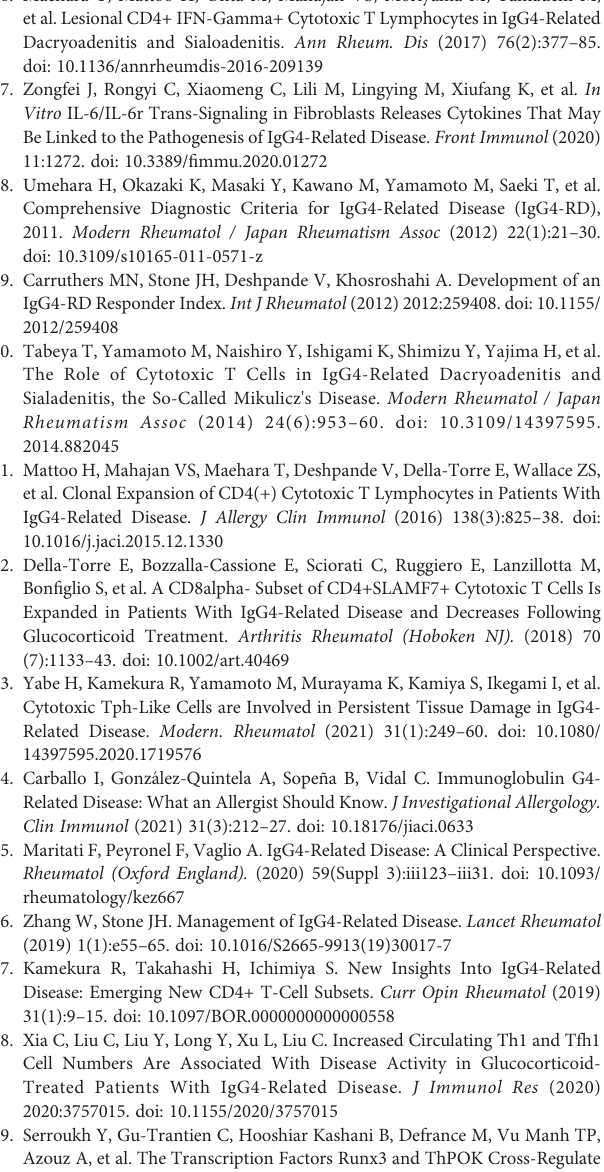
RD patients (n = 50). Each plot represented the data of one patient. The Spearman test ’ s correlation coef fi cient r and P values were listed, and the P values less than 0.05 were linearly regressed to show relevant trends. Supplementary Figure 3 | The effects of IL-7 on the percentages of GZMB+ cells in CD28- CTLs from IgG4-RD patients. PBMCs from IgG4-RD patients (n = 19) were stimulatedwith50ng/mLIL-7for4days. (A , B) ThepercentagesofCD4+CD28-GZMB + CTLs and CD8+CD28-GZMB+ CTLs in CD4+CD28- CTLs and CD8+CD28- CTLs from IgG4-RD patients were compared between IL-7-treated and untreated samples. TheerrorbarsrepresentedthemeanwithSD.Thepairedtwo-tailedStudent ’ st-testwas used to compare two groups. NS, not signi fi